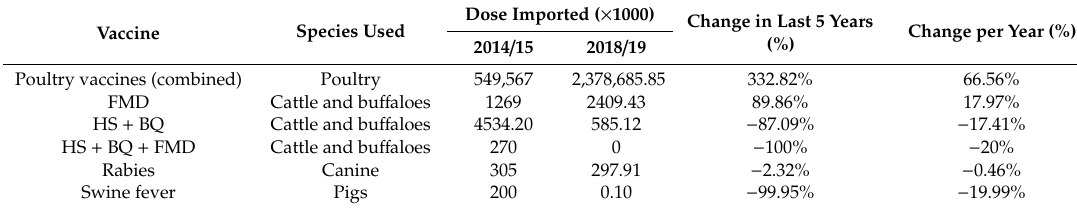
Table 6. Trend of livestock and poultry vaccine imports in Nepal